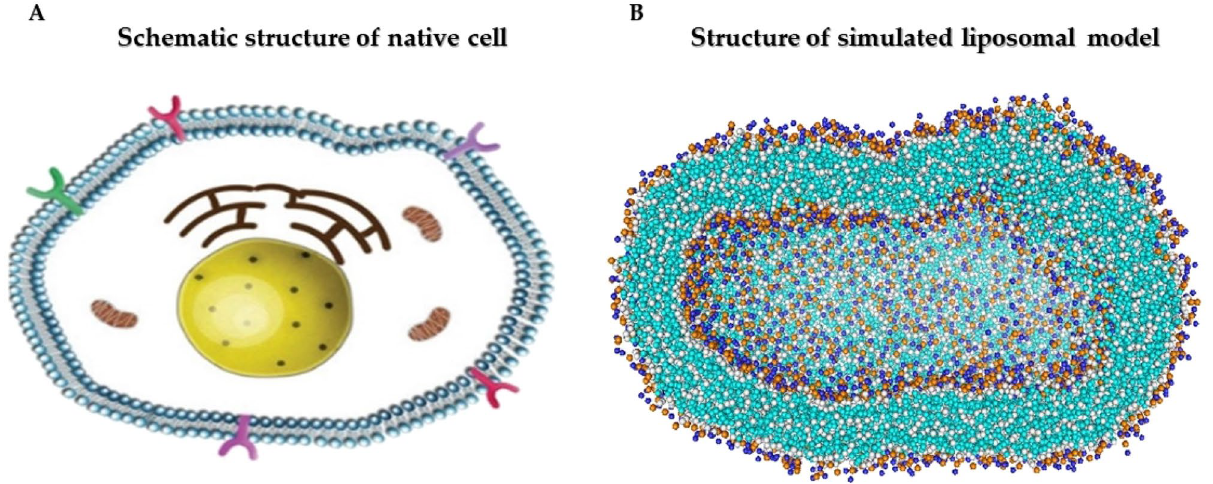
Figure 6. Comparison of the simulated liposome model and native cell